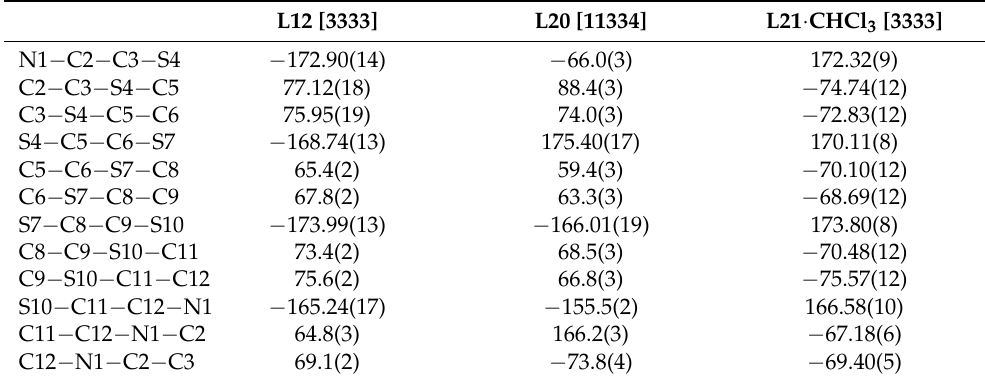
Table 1. Torsion angles ( ◦ ) for the [12]aneNS 3 moieties in L12 , L20, and L21 · CHCl 3 with the Dale conformations in bracket squares ( gauche torsion angles in red).